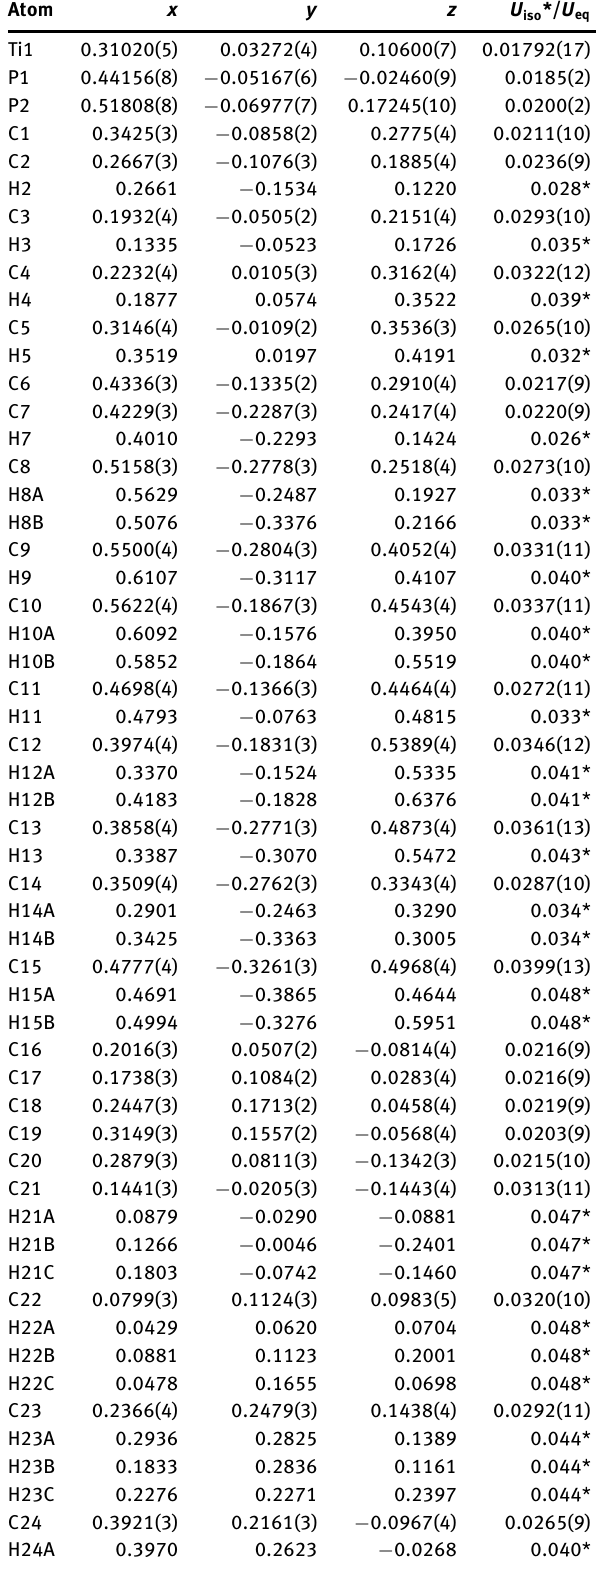
Table 2: Fractional atomic coordinates and isotropic or equivalent isotropic displacement parameters (Å 2 ).